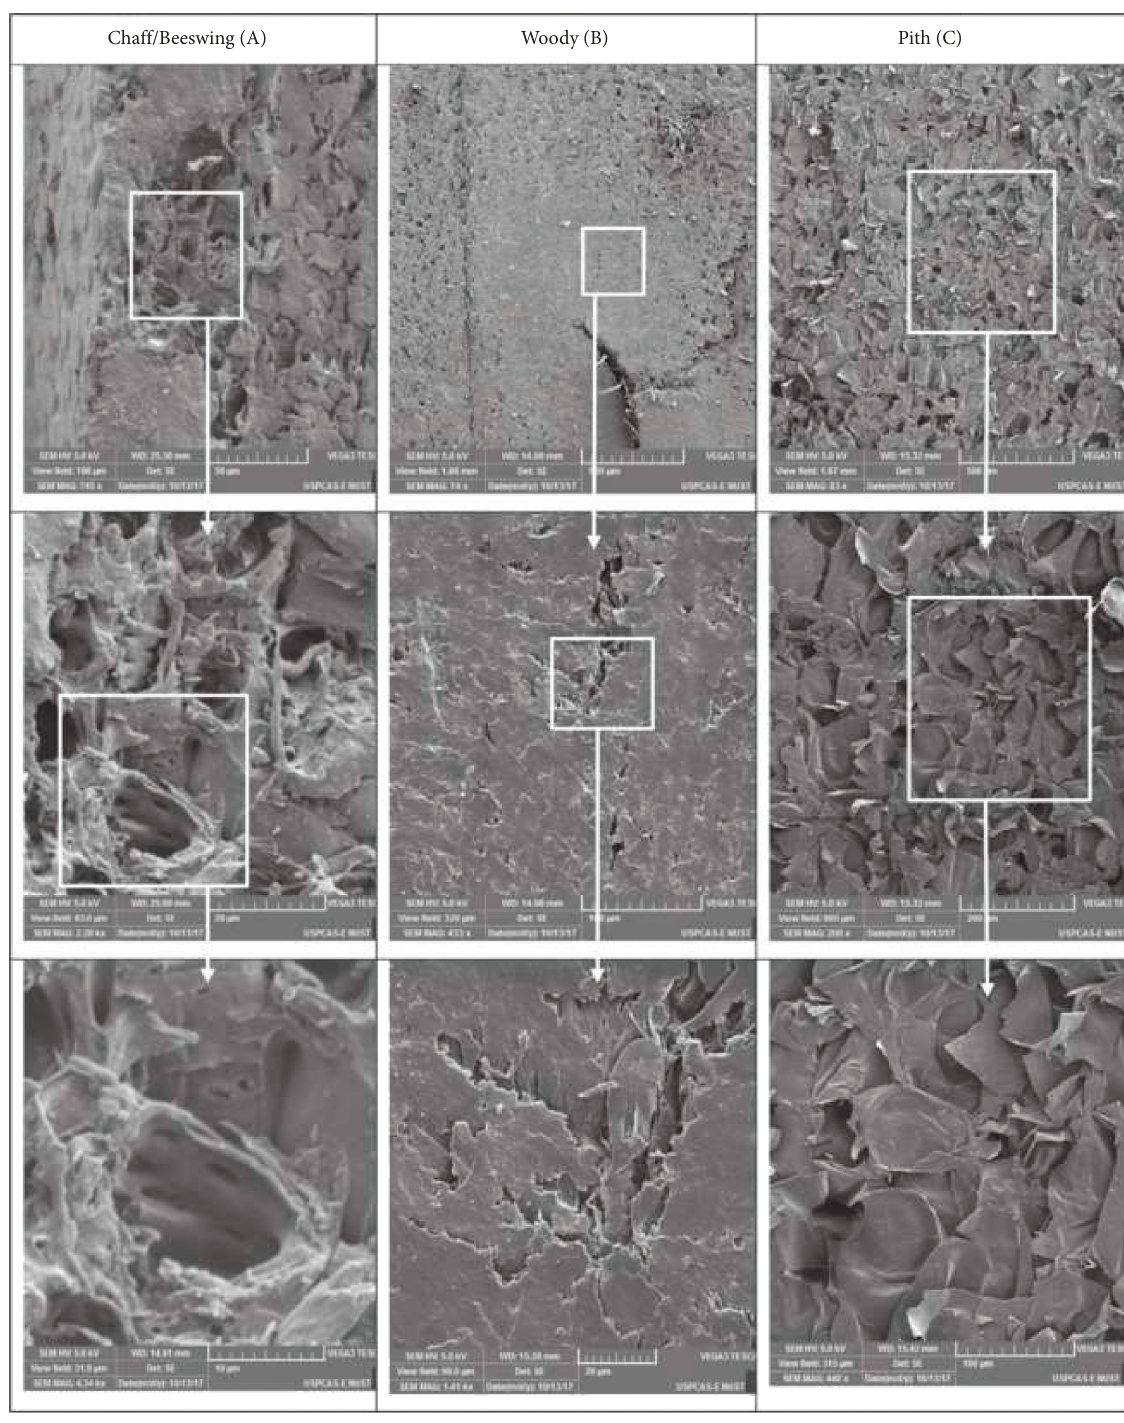
Figure 9: SEM macromorphology of corncob at different magnification